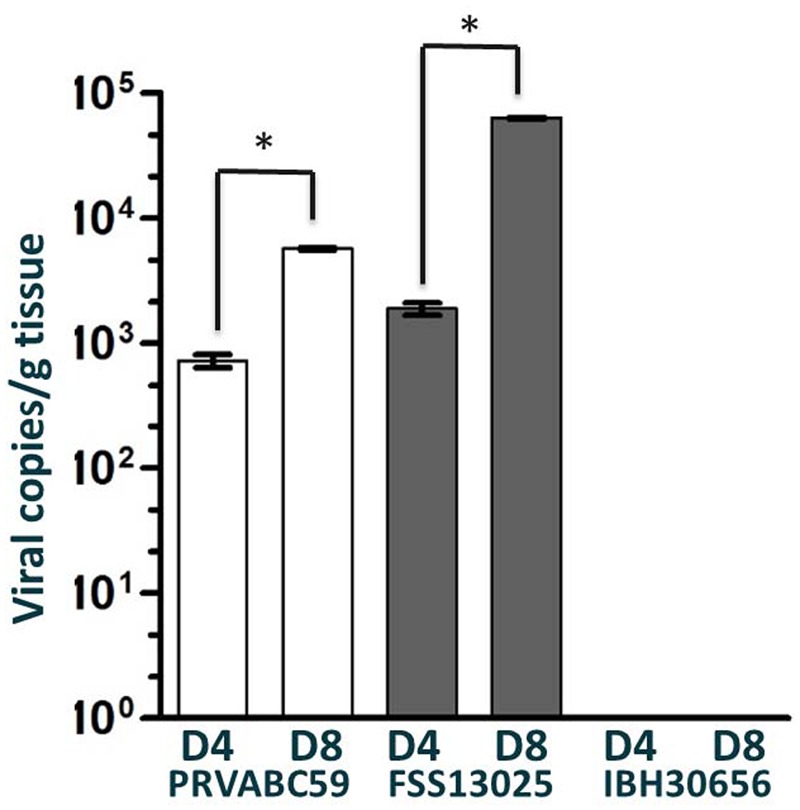
Viral load in the testes of ZIKV infected cynomolgus macaques. Viral load in the testes of cynomolgus macaques infected with PRVABC59, FSS13025, or IBH30656 were detected by qRT-PCR on days 4 and 8 p.i. Multiple sections of each testicle were tested independently and reported here are the sections with the highest viral load. ∗p-value < 0.05.